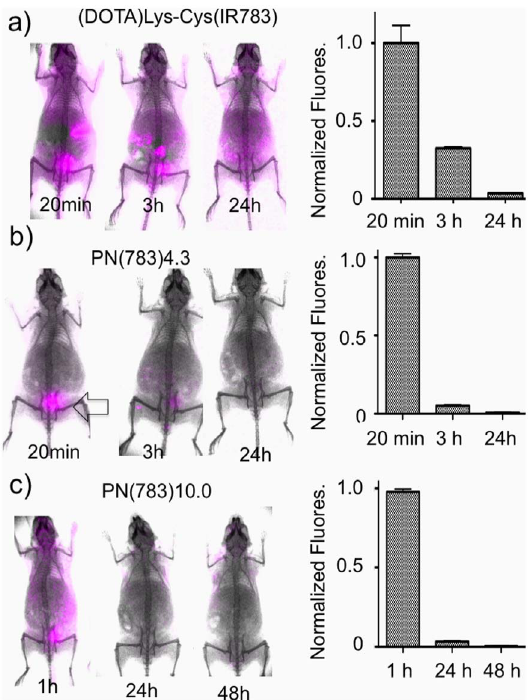
Figure 3. Role PEG in determining elimination by surface fluorescence imaging. A ) Animals were injected with unPEGylated peptide and imaged at the times indicated. Bar graph gives whole animal surface fluorescence determined as means and standard deviations, n=6. B ) With the 5 kDa PEG attached, PN(783)4.3 is obtained, which shows renal elimination within 20 minutes (arrow). C ) With the 30 kDa PEG, PN(783)10.0 is obtained, which shows a long vascular phase followed by elimination. Biodistribution and elimination of 111 In-PN(783)10.0 is shown in Figure 6.